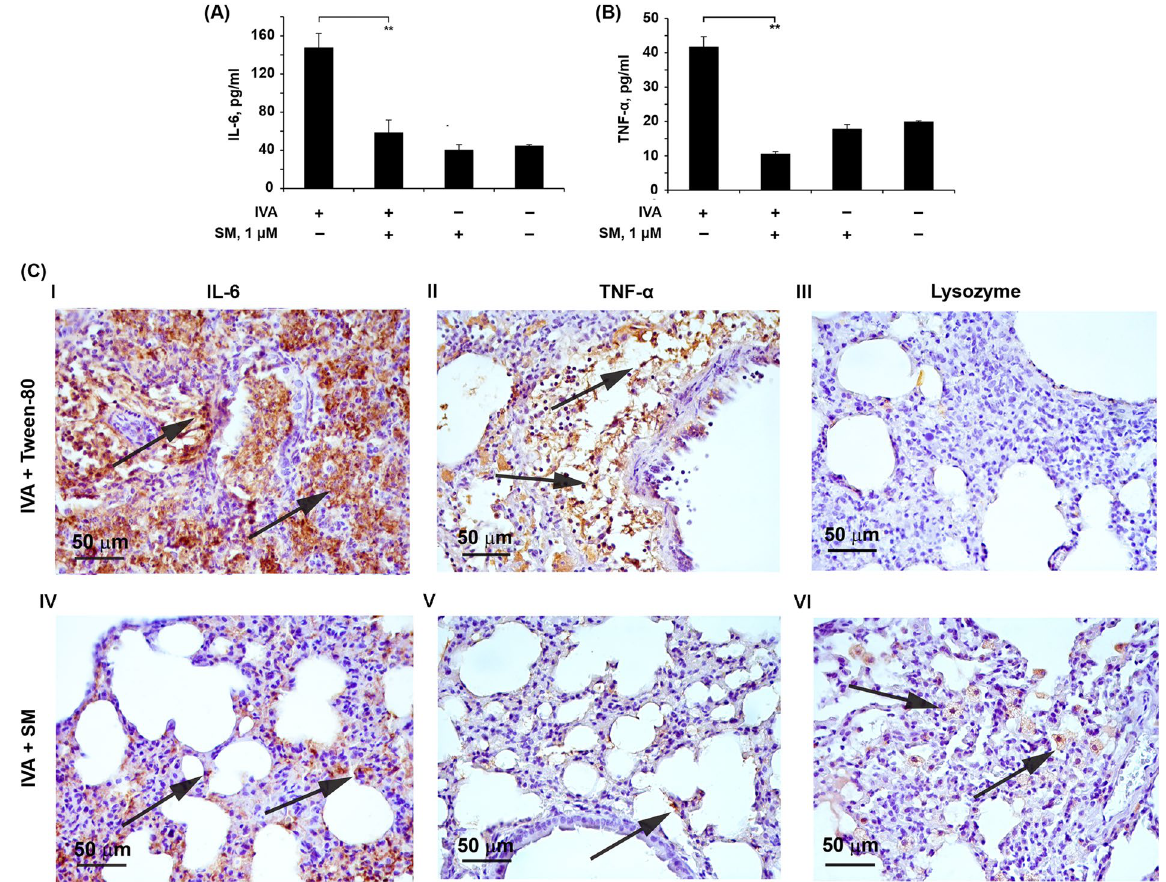
Figure 7. SM decreases pro-inflammatory cytokine production and improve factors of nonspecific resistance. A549 cells were infected with IVA at MOI 0.1 After 1 h of adsorption at 37 °C, the monolayers were washed twice with PBS and incubated with 1 µ M of SM for 24 h. The levels of IL-6 (A) and TNF- α (B) in the supernatants were evaluated by ELISA. Data are represented as the mean ± SD. p-value: ** p < 0.01. (C) Immunohistochemical staining of IL-6, TNF-alpha and Lysozyme positive cells in the lung tissue of IVA-infected mice treated with vehicle (10% Tween-80) (I, II, III) or 5 mg/kg of SM on day 5 p.i. (IV, V, VI). Arrows show IL-6 (I, IV), TNF-alpha (II, VII) and Lysozyme (III, VIII) positive cells in the lung tissue. Immunohistochemical staining of paraffin sections by anti-IL-6, anti-TNF-alpha and anti-Lysozyme monoclonal antibodies. Magnification 400 ×